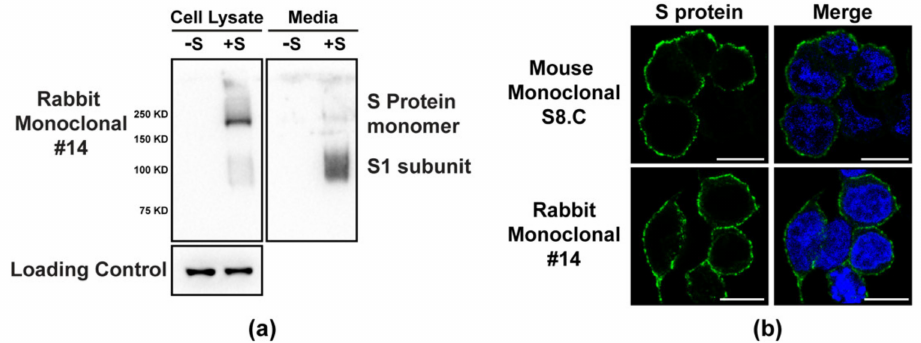
Figure 1. ( a ) Cell lysates and supernatants were collected from 293 cells transfected with constructs expressing S (+S) or N (–S) proteins of SARS-CoV-2 and subjected to Western blot analysis. Blots were probed with rabbit monoclonal #14 or actin (loading control for cell lysate only). ( b ) 293T cells transfected with a plasmid expressing SARS-CoV-2 S protein and subjected to IF analysis with S8.C mouse mAb or S #14 rabbit mAb at 24 h